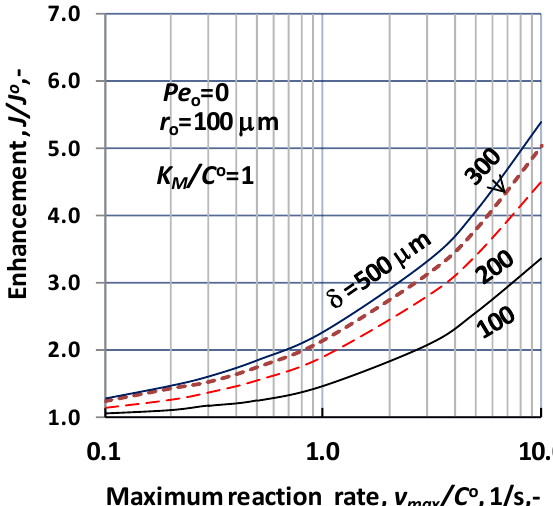
Figure 8. Enhancement as a function of the reaction rate, v max /C O , at different values of the biocatalytic membrane thickness, applying sweeping phase on the permeate side of the biocatalytic membrane reactor, d C /d R > 0 at R = R m ( N = 1000; r o = 100 μm; K M /C O = 1; D = 1.9 × 10 − 9 m 2 /s, Pe o = 0; J O = D/r o ).